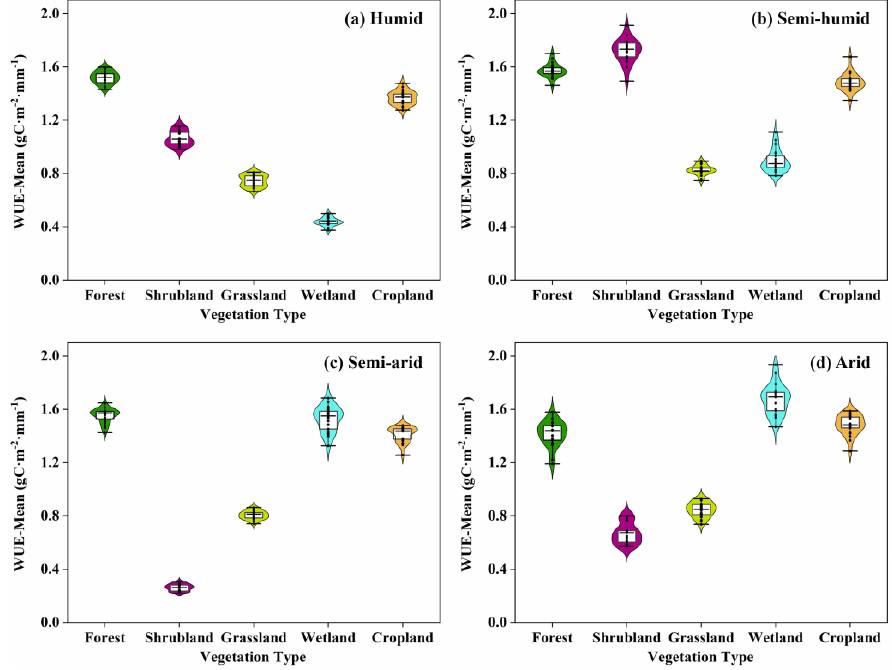
Figure 7. Distribution of WUE for different vegetation types in four arid-humid zones from 2001–2021. ( a – d ) represent the WUE distribution for each vegetation type in the humid, semi-humid, semi-arid, and arid zones. The upper, middle and lower lines of each violin plot represent the maximum, median and minimum values, the middle rectangle indicates the 25%~75% quantile. The width of the violin plot represents the intensity of the distribution of values.